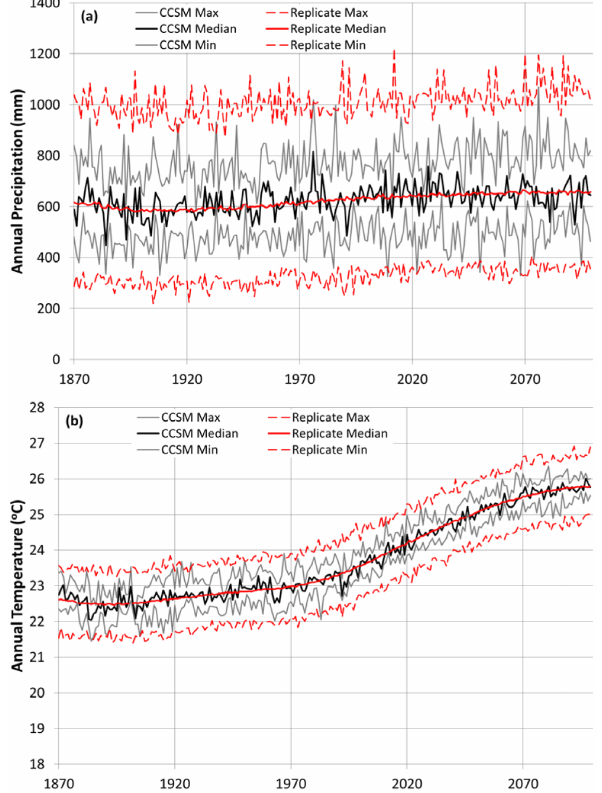
Figure 4. Within-GCM uncertainty for the Herbert River at Glenea- gle based on seven runs from the CCSM GCM compared with the stochastic approximation of within-GCM uncertainty for un-bias corrected (a) annual precipitation and (b) annual temperature. In each plot the maximum, median and minimum annual value for a given year are shown for the seven CCSM runs compared with the maximum, median and minimum of the 700 (7 × 100) stochastic replicates of the CCSM runs.